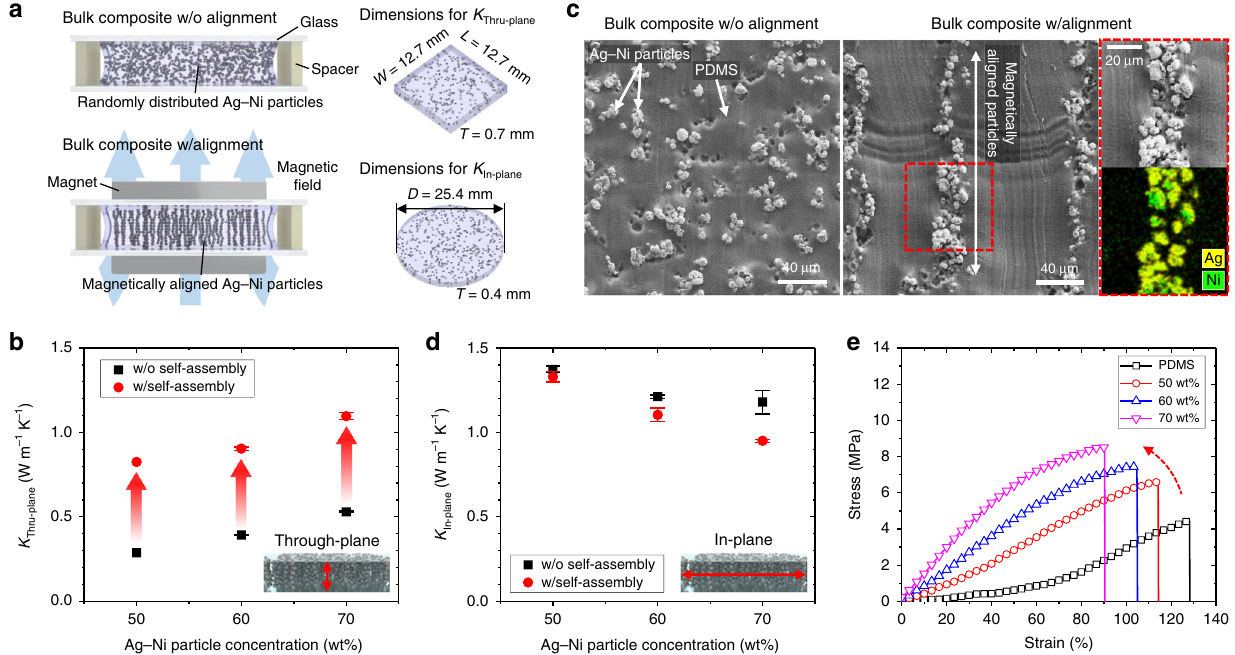
Fig. 2 Thermal and mechanical properties of s-HCs. a Schematic illustration of bulk Ag – Ni particle/polydimethylsiloxane (PDMS) composites without and with magnetic self-assembly for measuring the through-plane and in-plane thermal conductivity. b Through-plane thermal conductivity as a function of Ag – Ni particle concentration without and with magnetic self-assembly. The error bars represent the standard deviation. c Scanning electron microscope (SEM) images of bulk composites without and with magnetic self-assembly. A magni fi ed SEM image and an energy dispersive spectrometry (EDS) image showing the vertically aligned Ag – Ni particles are also included. Scale bars, 40 μ m. d In-plane thermal conductivity as a function of Ag – Ni particle concentration without and with magnetic self-assembly. The error bars represent the standard deviation. e Strain – stress curves of bare PDMS and magnetically self-assembled Ag – Ni particle/PDMS composites with different Ag – Ni particle